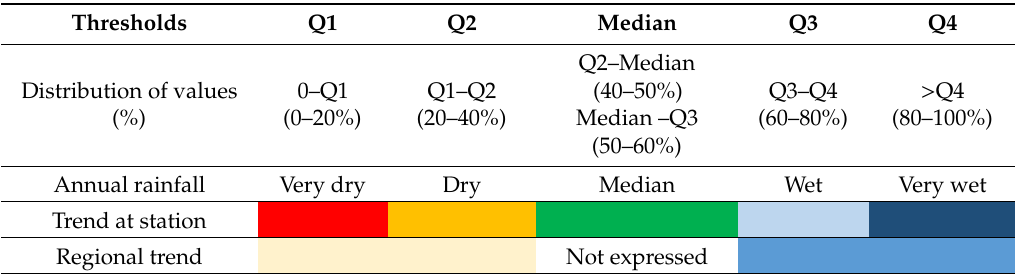
Table 2. Trend of annual rainfall according to the